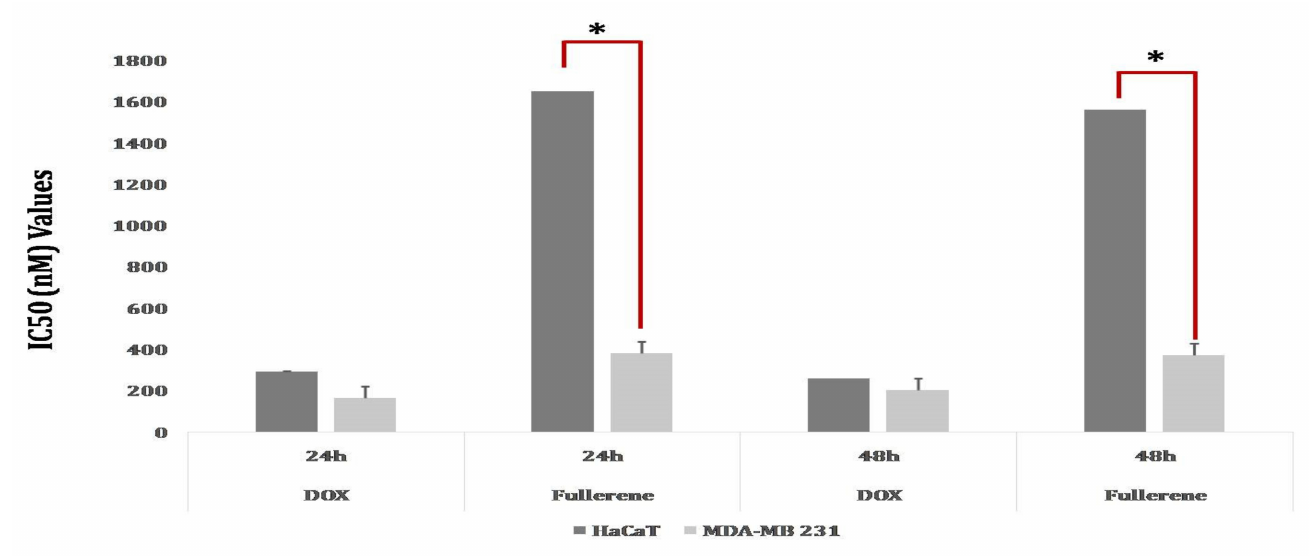
Figure 8. Cell viability [IC 50 value] of MDA-MB-231andHaCaT, after treatment with different nano- formulations [Dox: Doxorubicin [control], C 60 -AgNPs nanocomposite] after 24 h and 48 h. Error bar represents the standard deviation of the mean. * p ≤ 0.05. Significant difference ( p ≤ 0.05) within a parameter between two lines is denoted by an